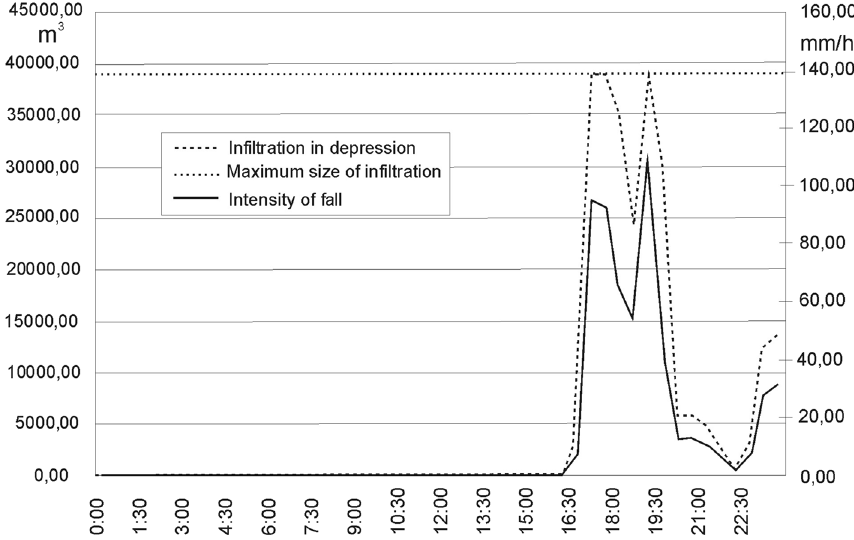
Fig. 16 Infiltration compared with precipitation on 9.07.2001 (Major and Cieśliński